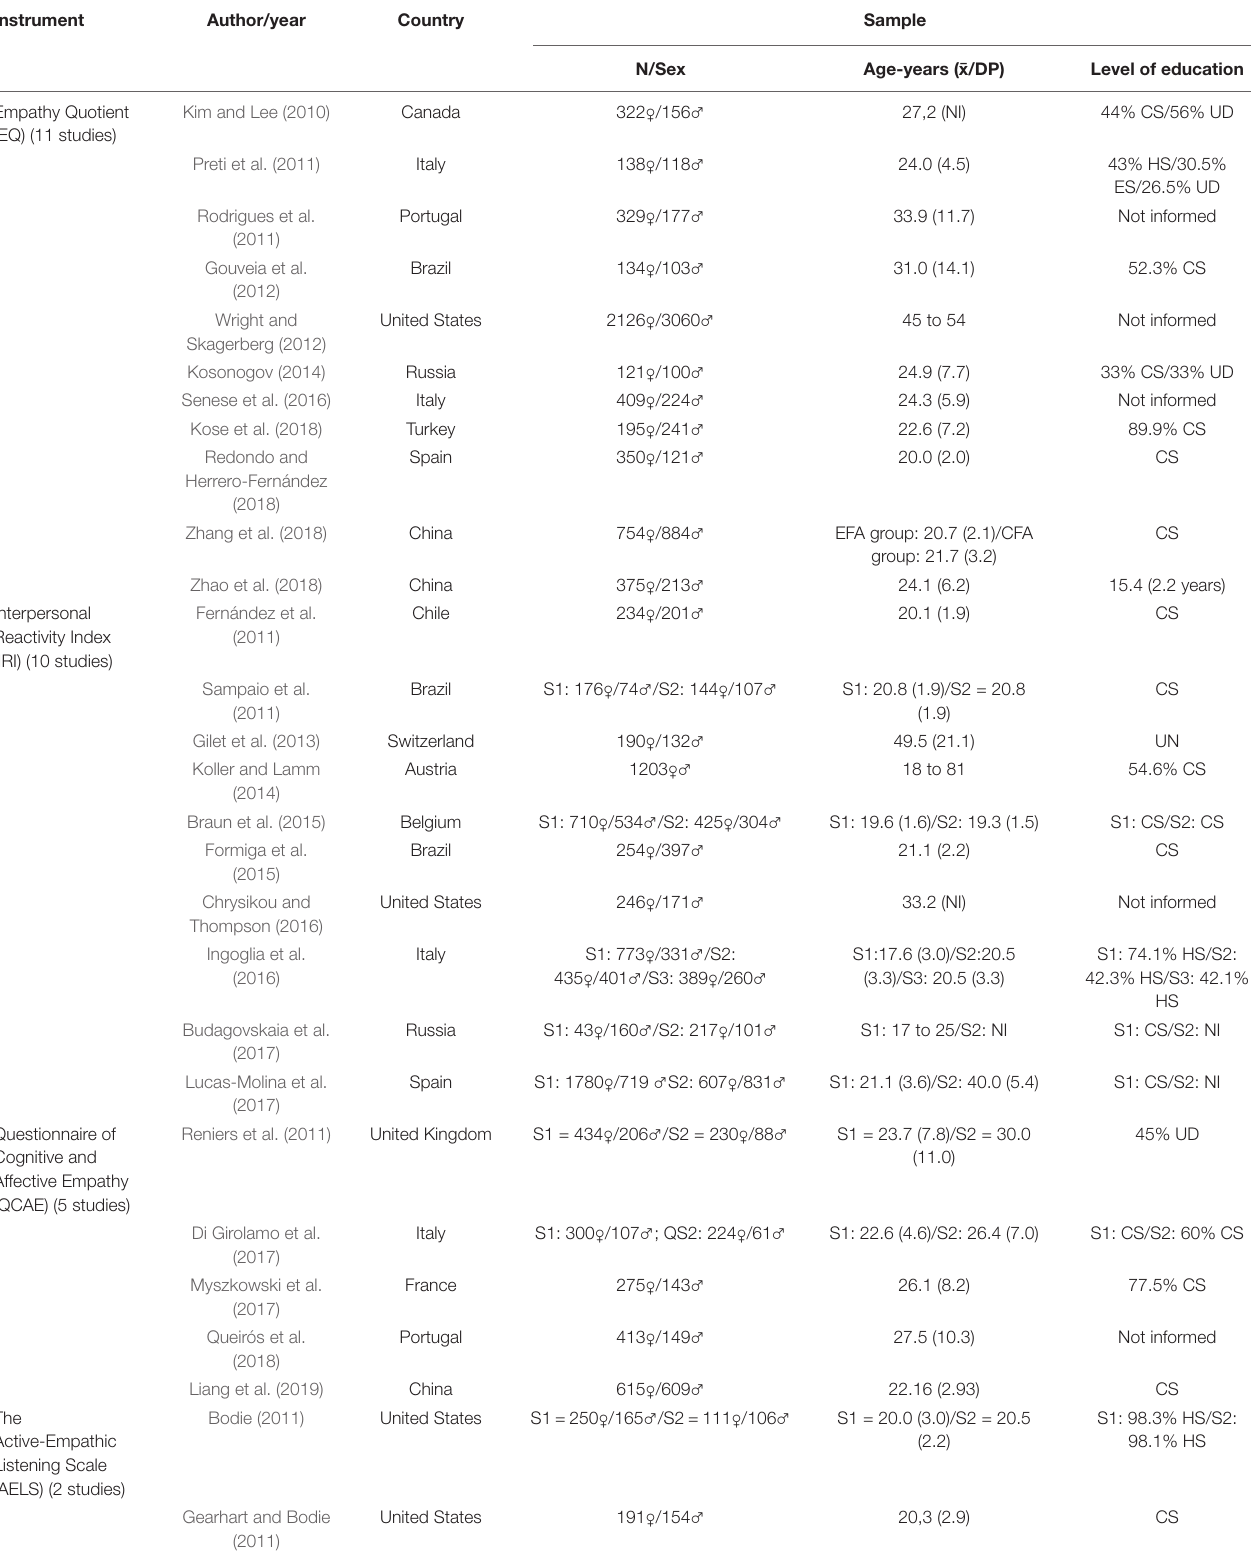
TABLE 2 | Characterization of the samples used by the different studies ( N = 50 – ranked from most studied to least studied). Instrument